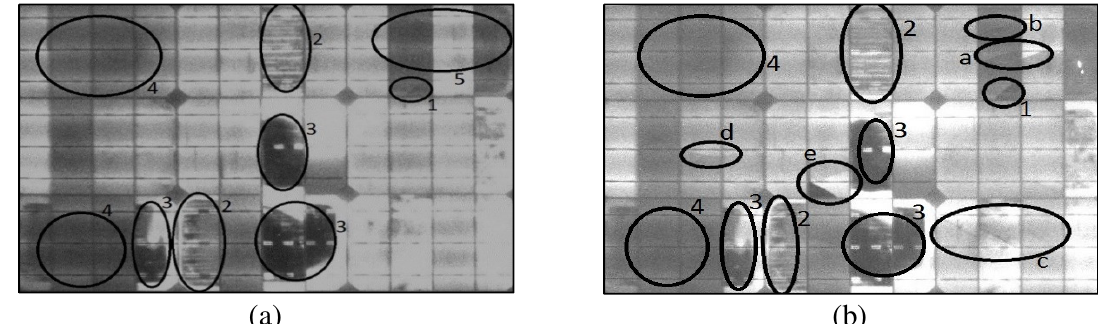
Fig. 2: Electroluminescence images of module 1: (a) before mechanical test and (b) after mechanical test